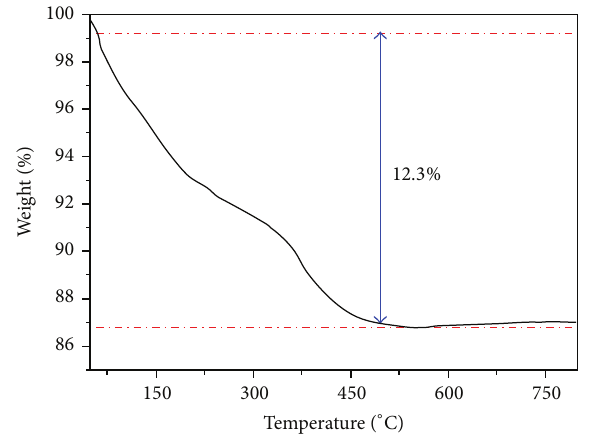
Figure 1: TGA curve of the precursor NiMoO 4 ⋅ n H 2